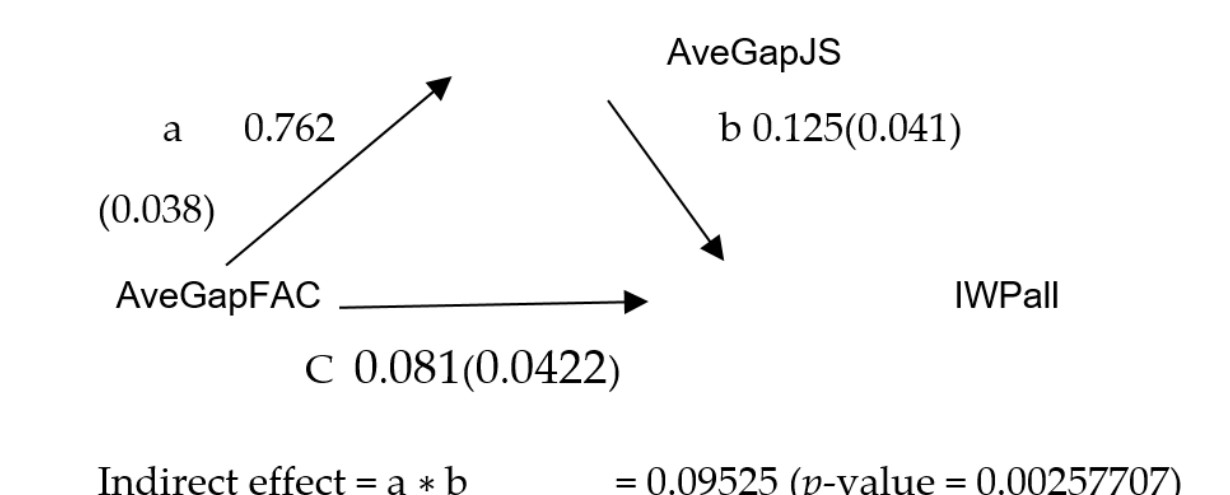
Figure 5. The mediating role of JSS in AveGapFAC and IWP.